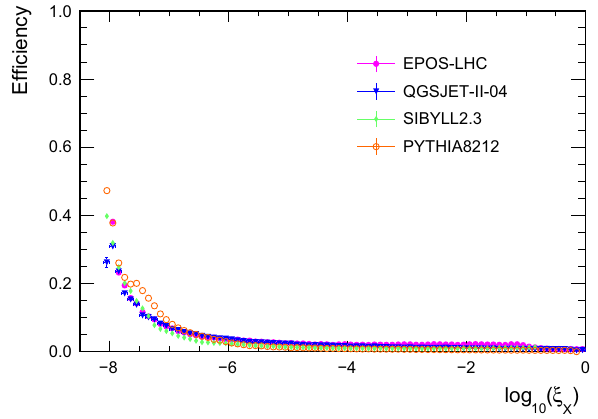
Fig. 12 SD ( pp → pX ; blue ) cross section as a function of log 10 ξ X predicted by using QGSJET-II-04 MC samples. This is compared with the SD cross section after applying the central-veto selection ( red